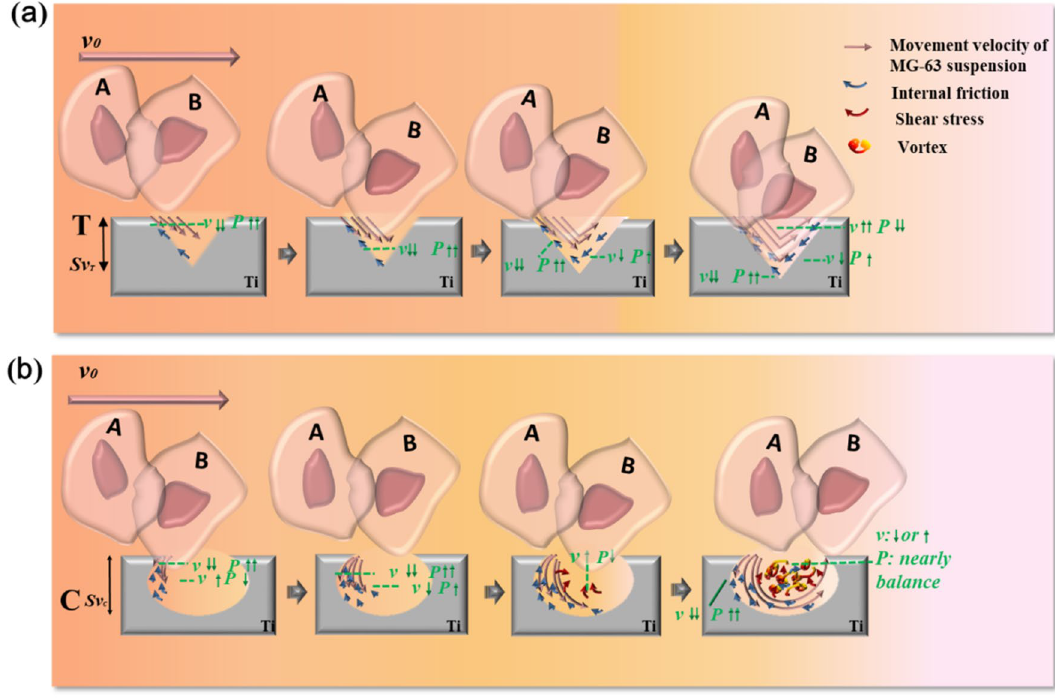
cell velocity; P : air pressure. This figure was generated by Adobe photoshop CC